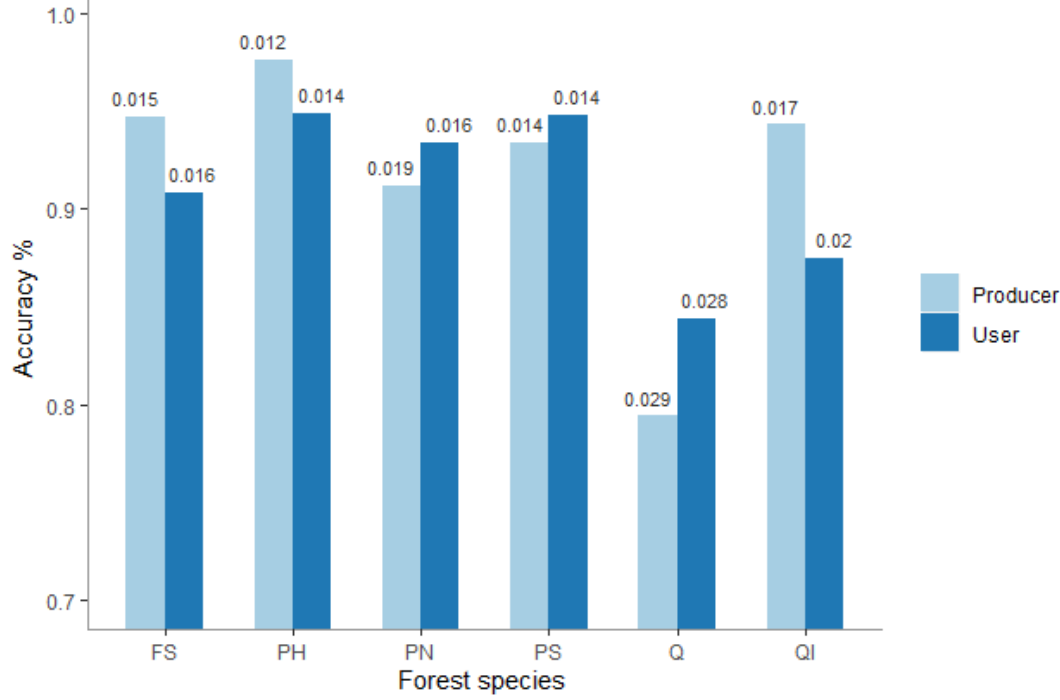
Figure 6. Mean and the standard error estimates (number at the top of each bar) of the accuracies (from 0 to 1) of the Landsat forest species maps over all the iterations for the main forest species of La